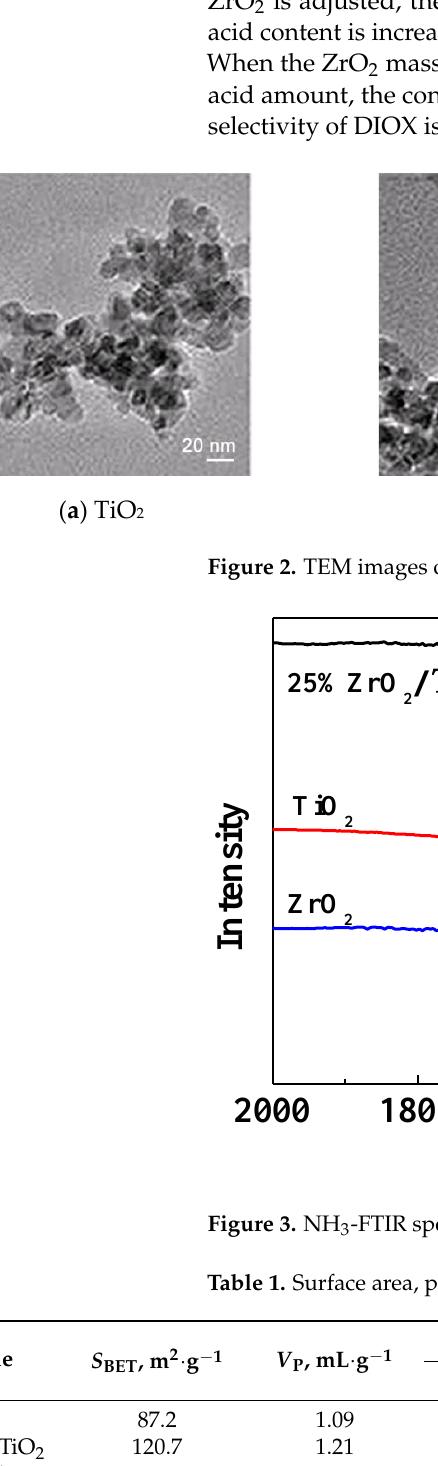
Figure 1. XRD patterns of samples.